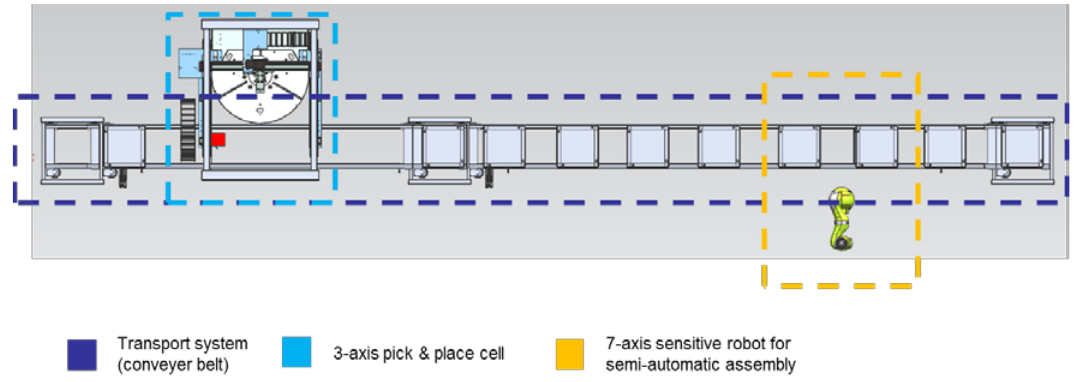
Figure 7. Created 3D CAD layout and positioned systems with the construction kit for evaluation (bird-view).